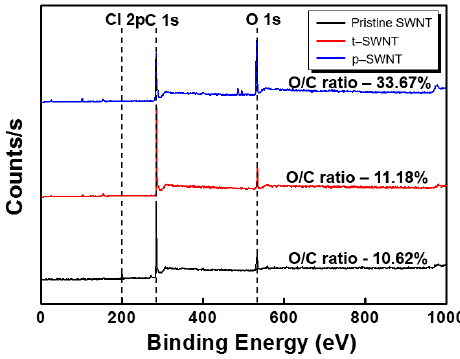
Figure 4. Changes of the core level spectra of SWNT by thermal- and plasma-cleaning treatments.